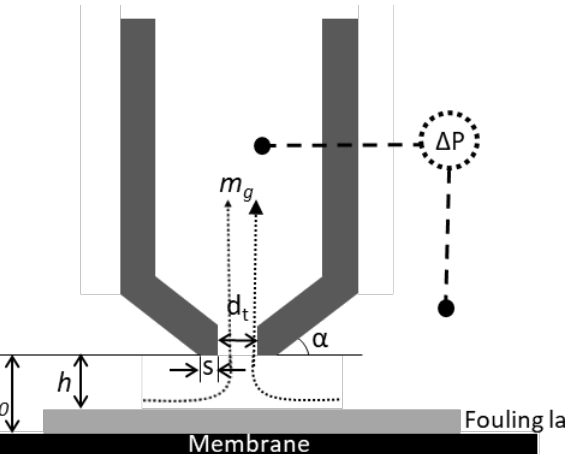
Figure 2. Schematic diagram of the FDG probe over a fouled membrane surface. The probe used in this study had the following dimensions: inner diameter of the nozzle, dt, was 0.5 mm, while the nozzle rim, s, was 0.25 mm, and α = 45°. mg is the gauge flow, and ΔP is the pressure drop over the probe, while h 0 and h are the clearing heights over the membrane and the fouled membrane, respectively.